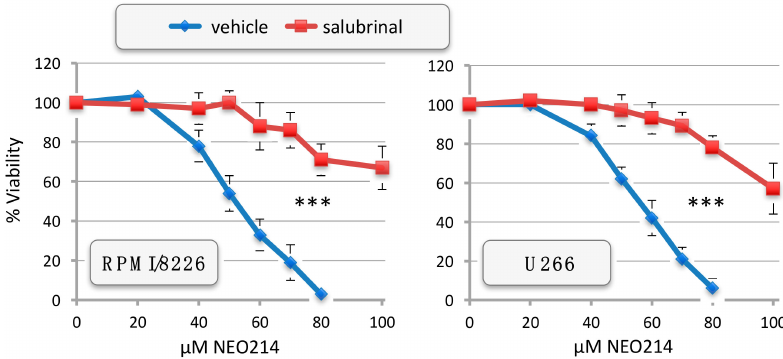
Figure 7. Salubrinal antagonizes NEO214 toxicity. RPMI/8226 and U266 cells were treated with increasing concentrations of NEO214 in the presence or absence of 75 µ M salubrinal. After 48 h, cell viability was determined by standard MTT assay. Similar results were obtained at 24 h and at 72 h. Asterisks (***): p < 0.001 between salubrinal and vehicle at NEO214 concentrations ≥ 50 µ